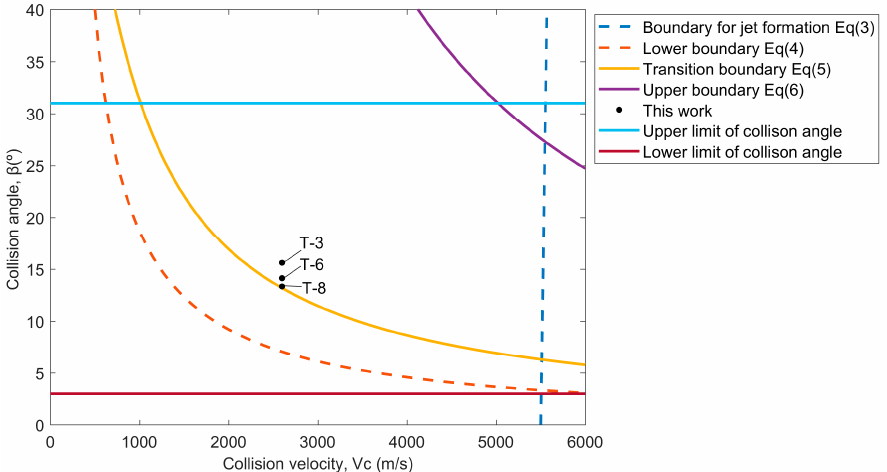
Figure 6. The calculated weldability window of 0.1 mm W–Cu for explosive welding.